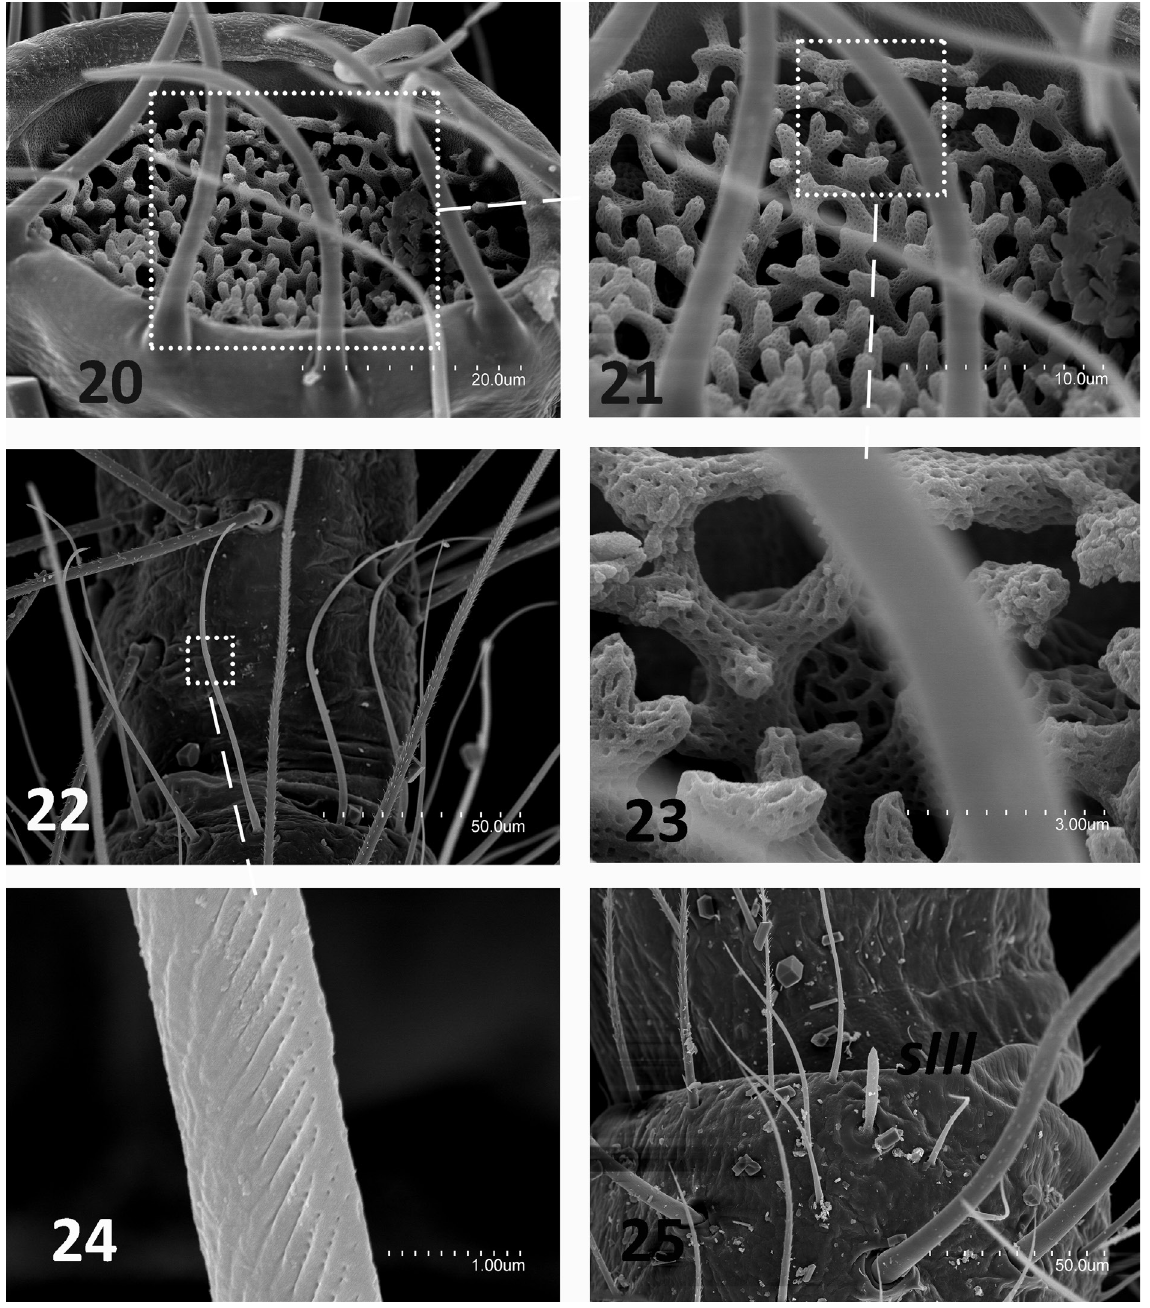
Figs 20‒25. Hubeicampa melissa Sendra & Lips gen. et sp. nov. 20 . Apical view of the last antennomere. 21 . Ramiform net of the olfactory chemoreceptor in the cupuliform organ. 22 . Distal portion of a central antennomere. 23 . Detail of the ramiform net of the olfactory chemoreceptor. 24 . Detail of the gouge sensillum. 25 . Ventral side of the third antennomere with its sensillum ( sIII